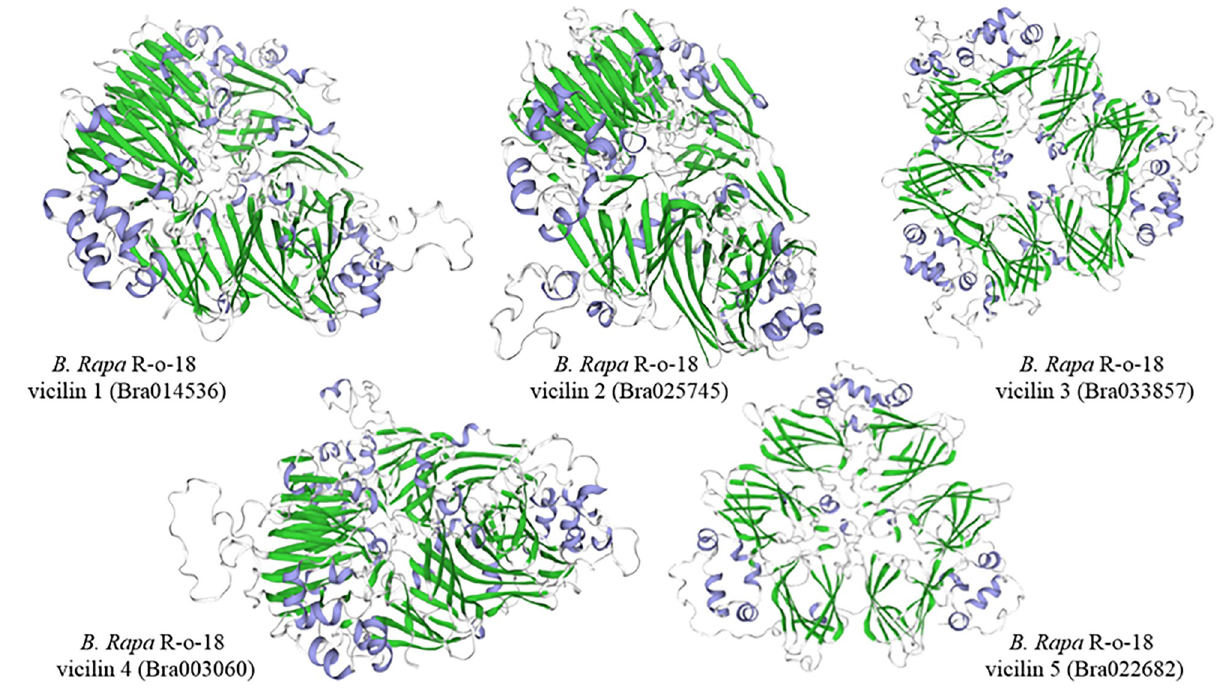
Fig 7. Three-dimensional structure of the vicilin like seed storage proteins identified in Brassica rapa . Structural modelling was carried out using the SWISS-MODEL program and was based on the available crystal structures of vicilin (S6 Table in S1 File). The green shading indicates the location of β -sheets in the N-terminal region and the blue shading indicates α -helices at the C-terminus.